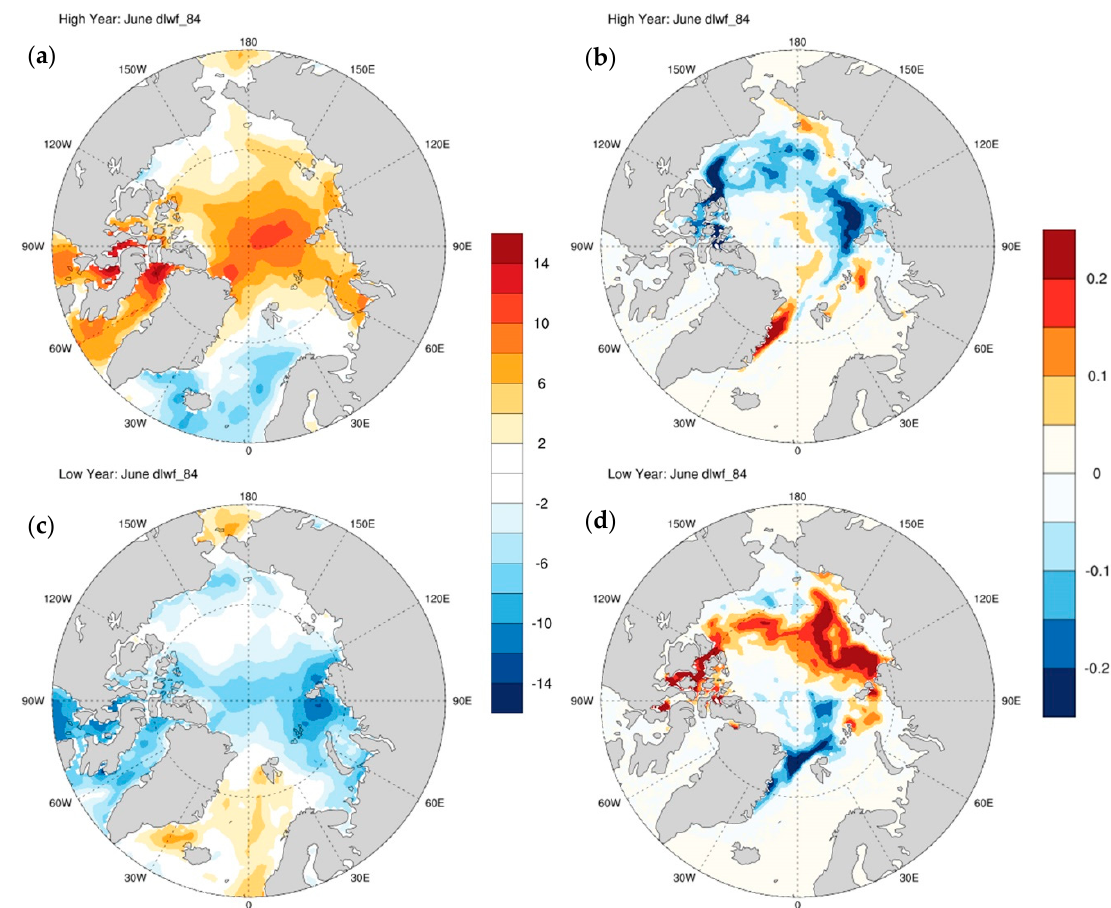
Figure 8. Composite anomalies of ( a , c ) June DLWF (contour interval: 2 W/m 2 ) and ( b , d ) September SIC (contour interval: 0.05). The top (bottom) two plots correspond to the years when June dlwf_84 (69.0° N, 89.3° W) is one standard deviation larger than its climatology mean in the positive (negative) phase.